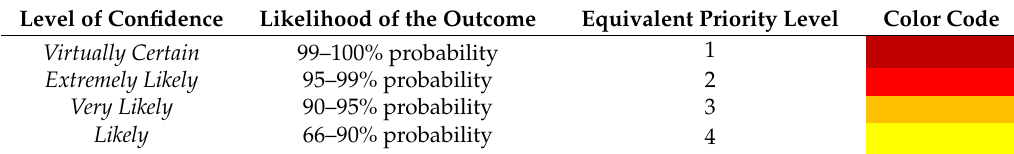
Table 2. Confidence and Likelihood of the Coastal Zone experiencing the CC Variables in Table 1.